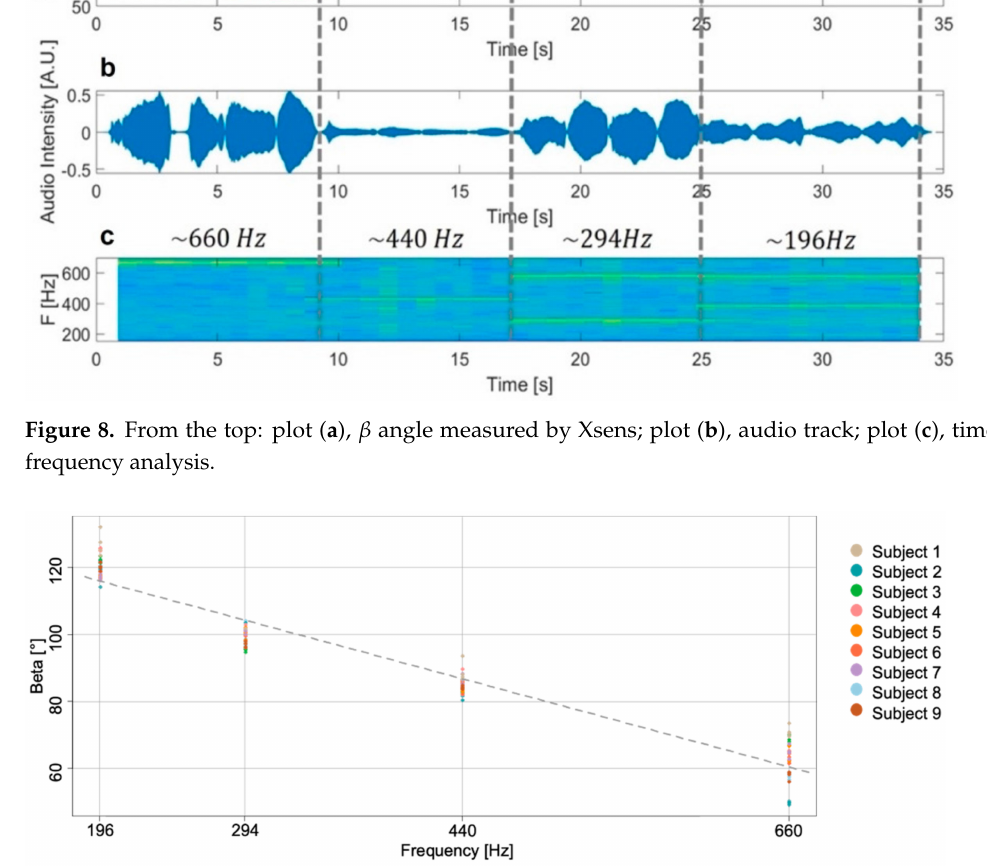
Figure 9. The plot shows the β angle averaged in each stroke vs. the corresponding string frequency. Data from each subject are identified with a different color. The dashed gray line represents the overall regression line ignoring the subject